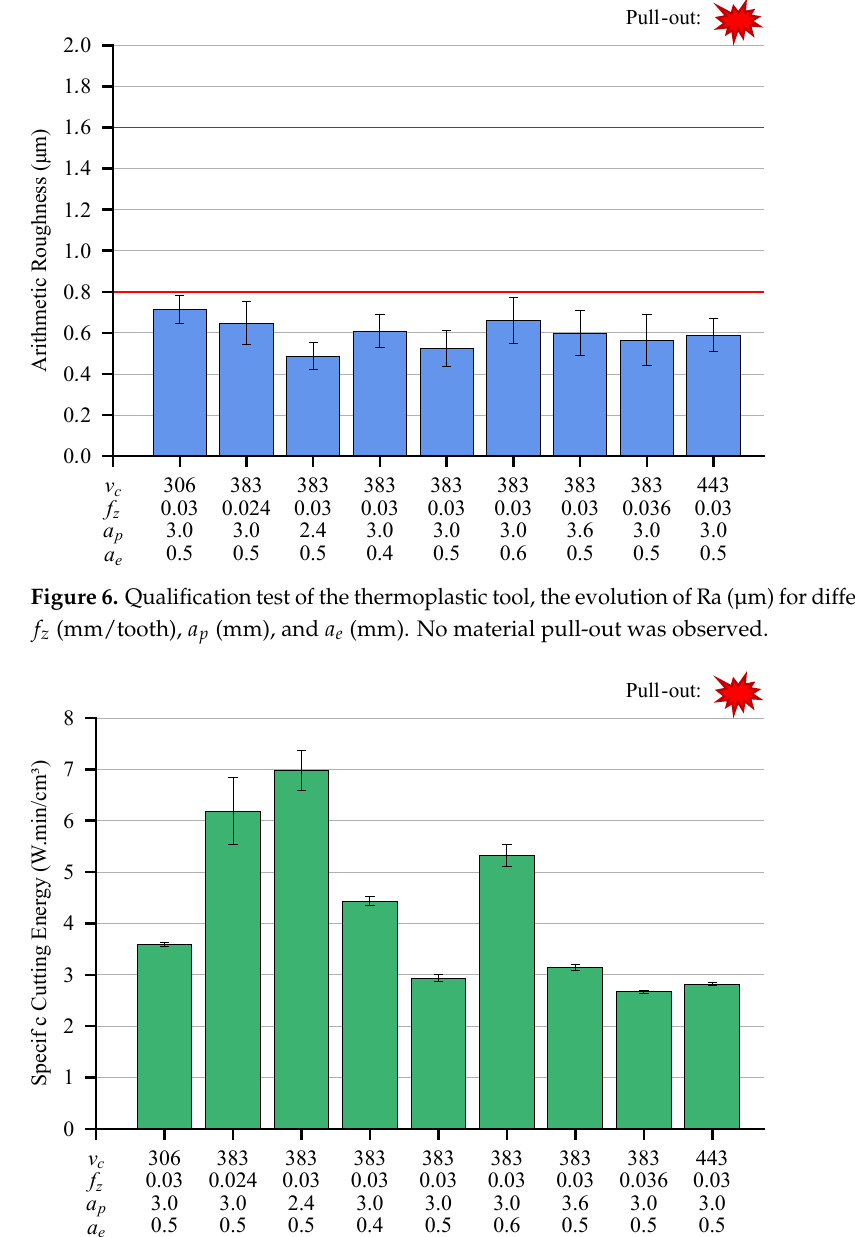
Figure 7. Qualification test of the thermoplastic tool, evolution of W c (W · min/cm 3 ) for different v c (m/min), f z (mm/tooth), a p (mm), and a e (mm). No material pull-out was